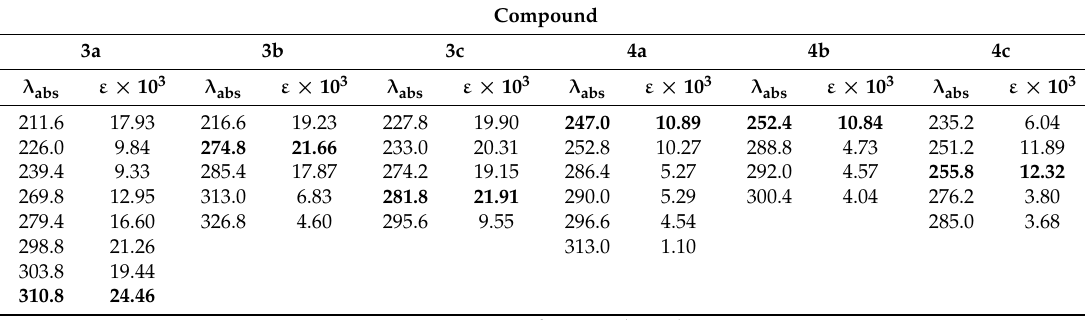
Table 2. Absorption ( λ abs and ε ) for the benzofuran derivatives 3a – c and 4a – c in cyclohexane.